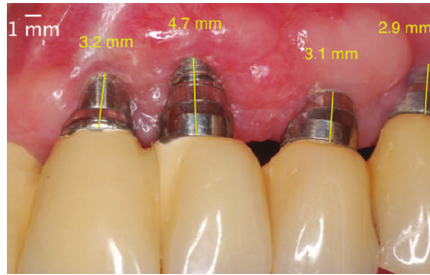
Figure 15: Two years after the surgery. Covering all of the threads of the implant and the platform due to the phenomenon of “creeping attachment.”